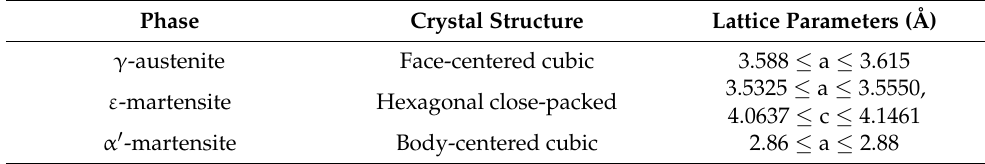
Table 3. Crystal feature of the major phases present in Fe-Mn-Si-Cr-Ni alloys.